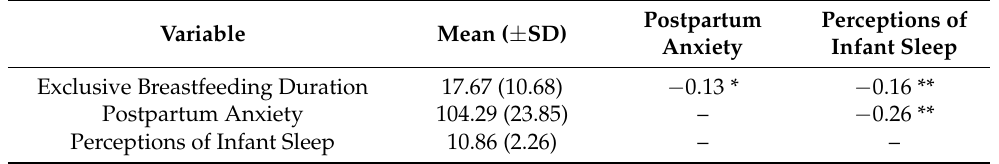
Table 2. Descriptive statistics and Pearson’s correlations for exclusive breastfeeding duration, post- partum anxiety, and perceptions of infant sleep.